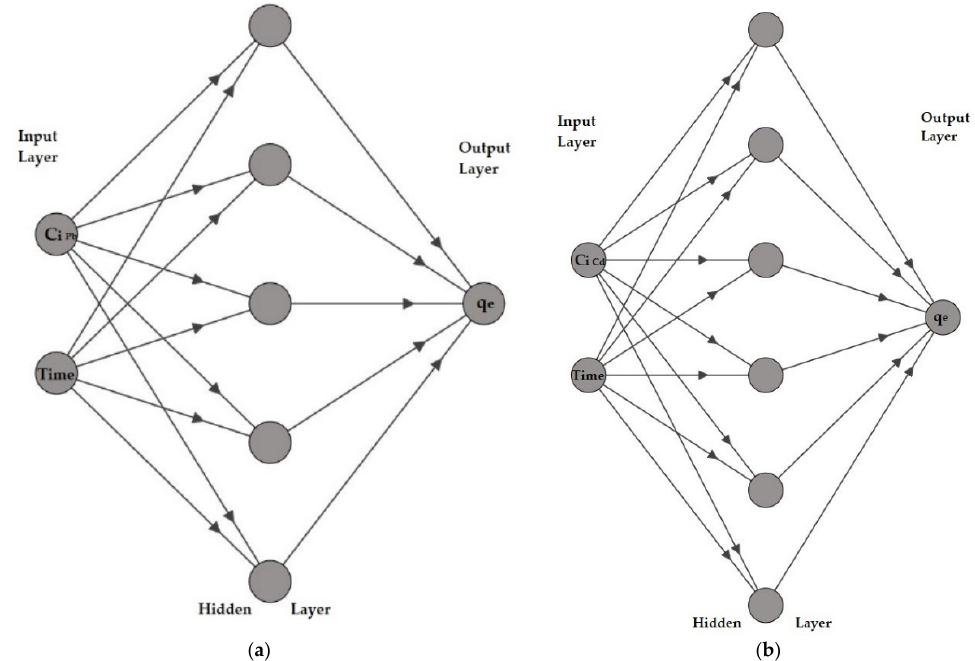
Figure 15. ANN architectures for ( a ) Pb and ( b ) Cd adsorption modeling onto CHIT-PAAA